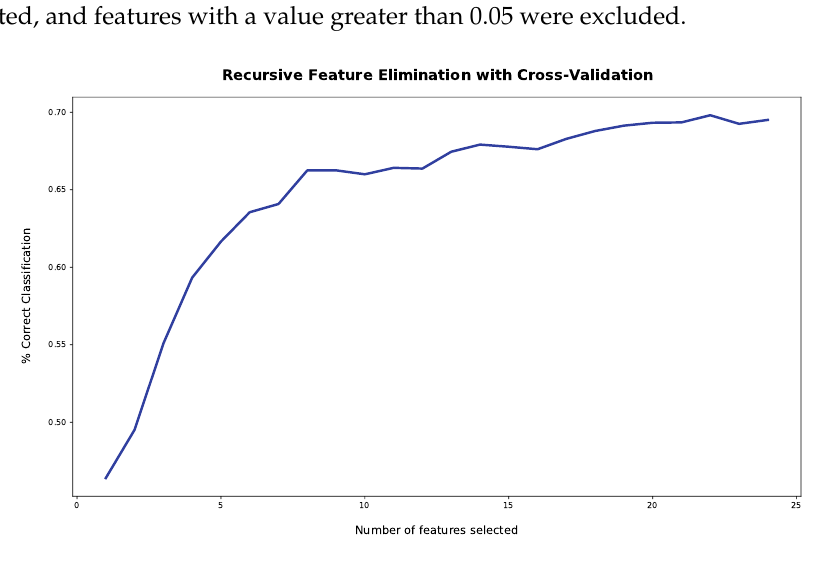
Figure 5. Recursive feature elimination with